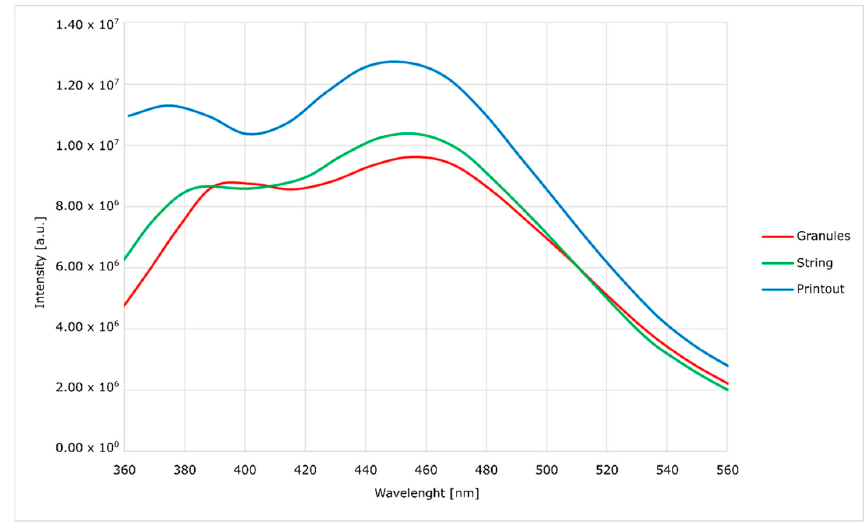
Figure 7. Emission spectra of nanosilica-modified PC .